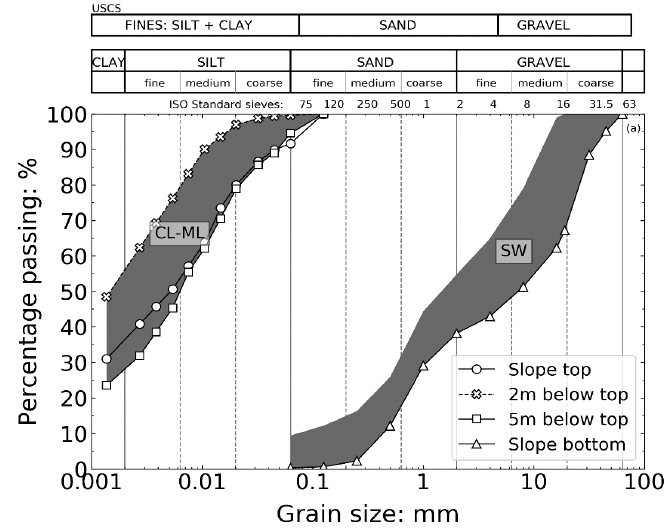
Figure 5. Representative grain size distributions from the slope surface.